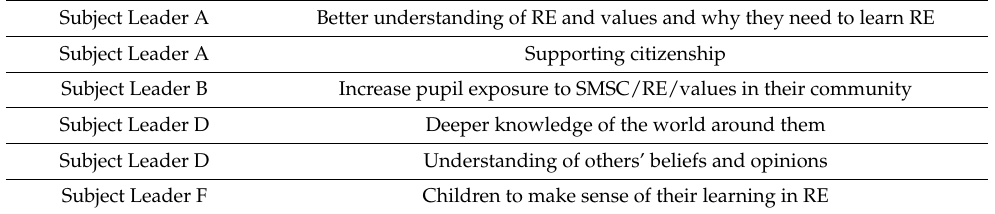
Table 2. Meaning-making: aligned with self-awareness and